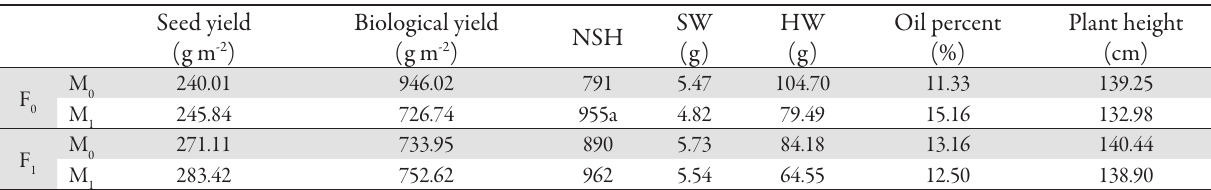
Tab. 4. Interaction effects of Fe and Mn applications on oil percentage , biological and seed yield, yield components and plant height of